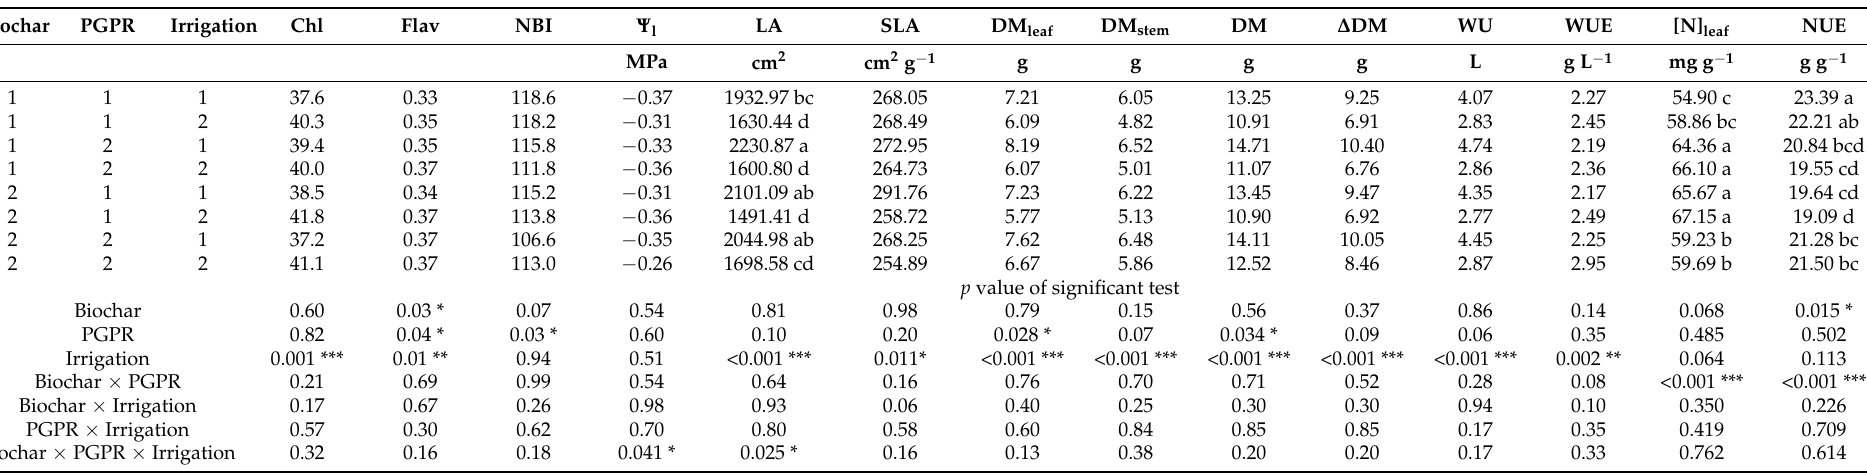
Table 2. Change of chlorophyll (Chl), flavonoids (Flav), nitrogen balance index (NBI), leaf water potential ( Ψ l ), leaf area (LA), leaf dry mass (DM leaf ), stem dry mass (DM stem ), specific leaf area (SLA), total dry mass (DM), dry mass increment ( ∆ DM), water use (WU), water use efficiency (WUE), leaf N concentration ([N] leaf ) and nitrogen use efficiency (NUE) as affected by biochar, PGPR and irrigation at final